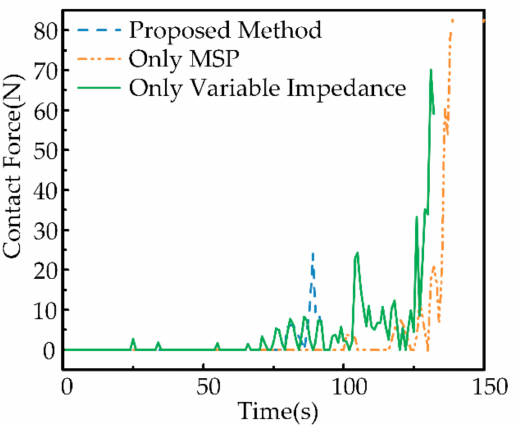
Figure 20. Results of operation of robots with different control